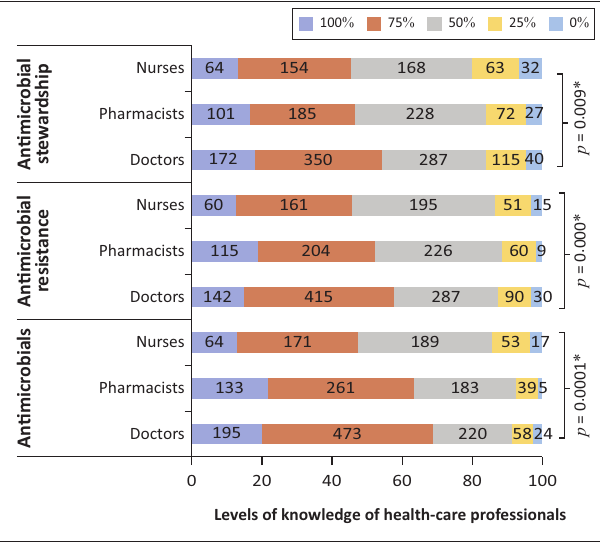
FIG URE 1: Healthcare professionals’ self-assessment of their levels of confidence on knowledge of antimicrobials, antimicrobial resistance and antimicrobial